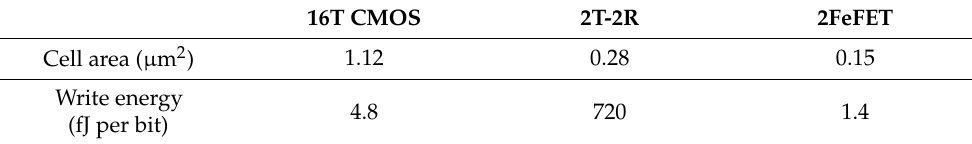
Figure 9. TCAM cell designs based on: ( a ) CMOS static random access memory required 16 transistors, BL, bit line, ML, pre-charged matchline, SL, search line, WL, write line, ( b ) based on resistive storage elements, ( c ) based on four CMOS FET and two FeFETs, ( d ) based on two FeFETs [https://arxiv.org/abs/2101.06375 Access Date: 10.12.2022]. Table 3. TCAM cell parameters [26].